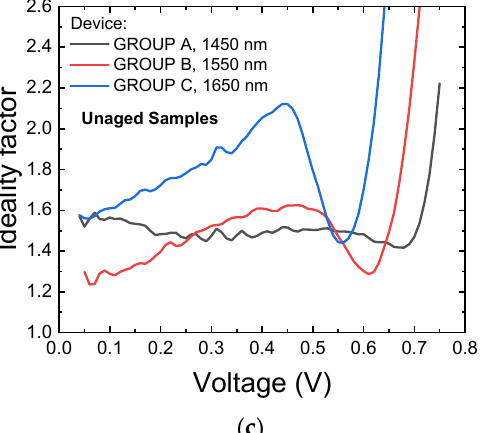
Figure 1. Electrical characteristics of one representative unaged sample for each of the LED groups under investigation, reported ( a ) in semilog scale and ( b ) in linear scale. Plot ( c ) reports the bias-dependent ideality factor calculated for each sample. The measuring temperature during these characterizations was set to T AMB = 25 °C.